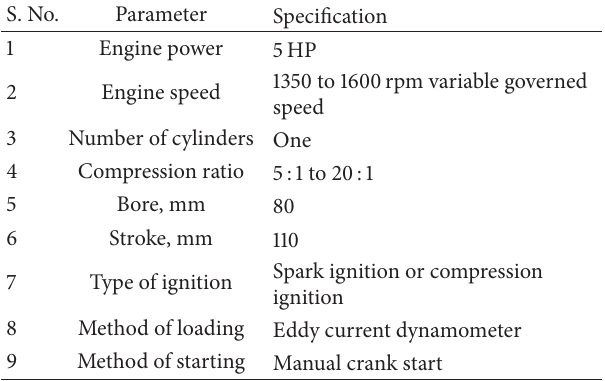
Table 2: Brief specification of variable compression ratio (VCR)